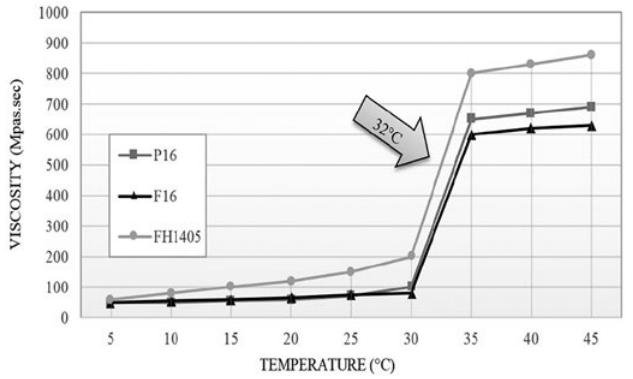
FIGURE 3 - Effect of temperature on viscosity of formulations (n=6).